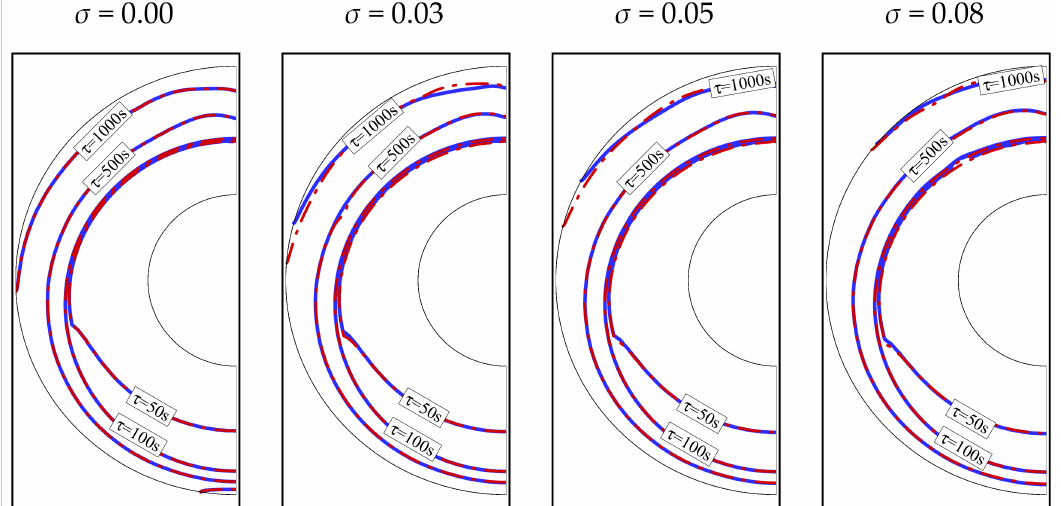
Figure 12. The interfaces of melting for different volume fractions of nanoadditives at four charging times with an eccentricity e of 0.12 r s and a porosity ε of 0.8. Solid lines are for graphite oxide nanoparticles, and dashed lines are for copper nanoparticles.